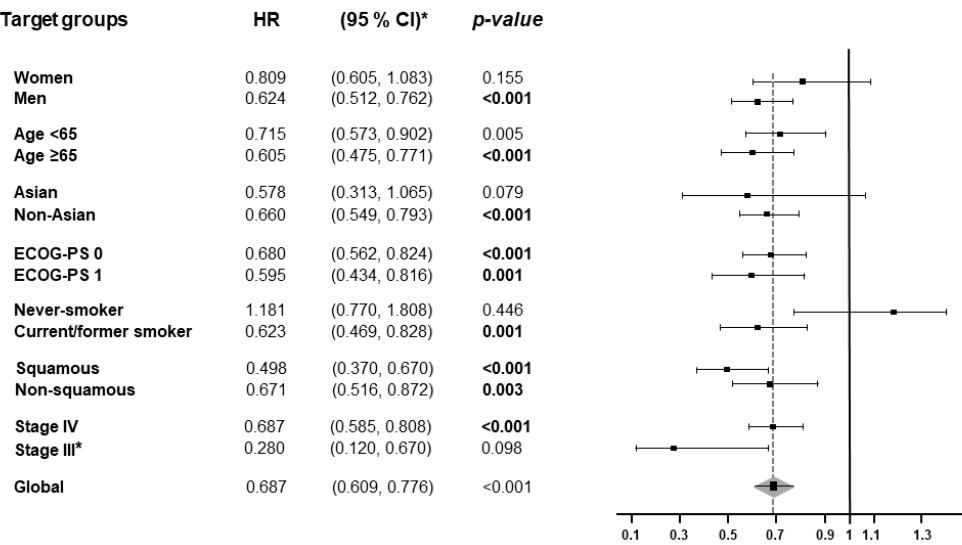
Figure 3. Forest plot of hazard ratios for overall survival (OS) in the subgroup analysis. HR, hazard ratio; CI, confidence interval. * Only KEYNOTE-042 included patients with stage III NSCLC.